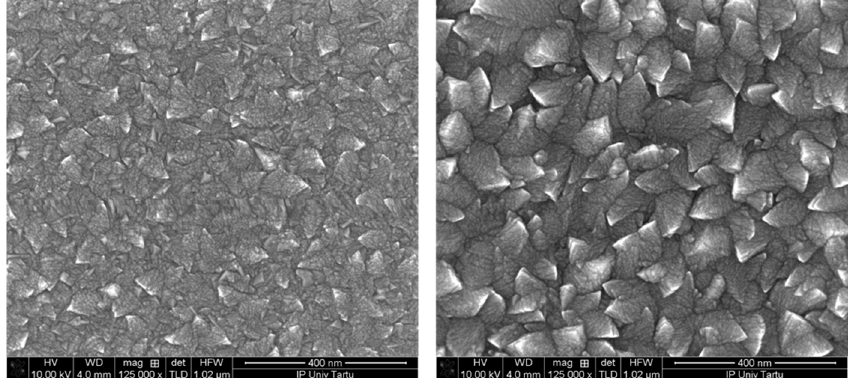
Figure 4. Representative SEM images of the 94 nm (5000 cycles, left panel ) and 158 nm (10,000 cycles, right panel ) thick CuO films.